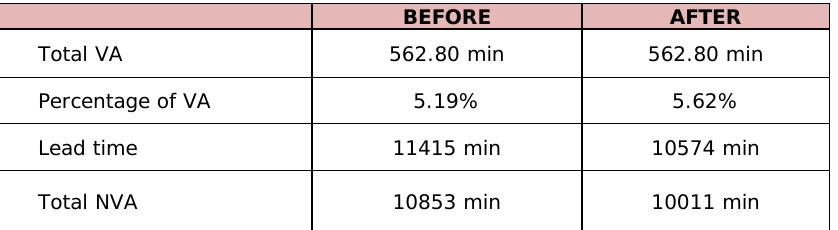
Table 1. “Current vs. Future State VSM